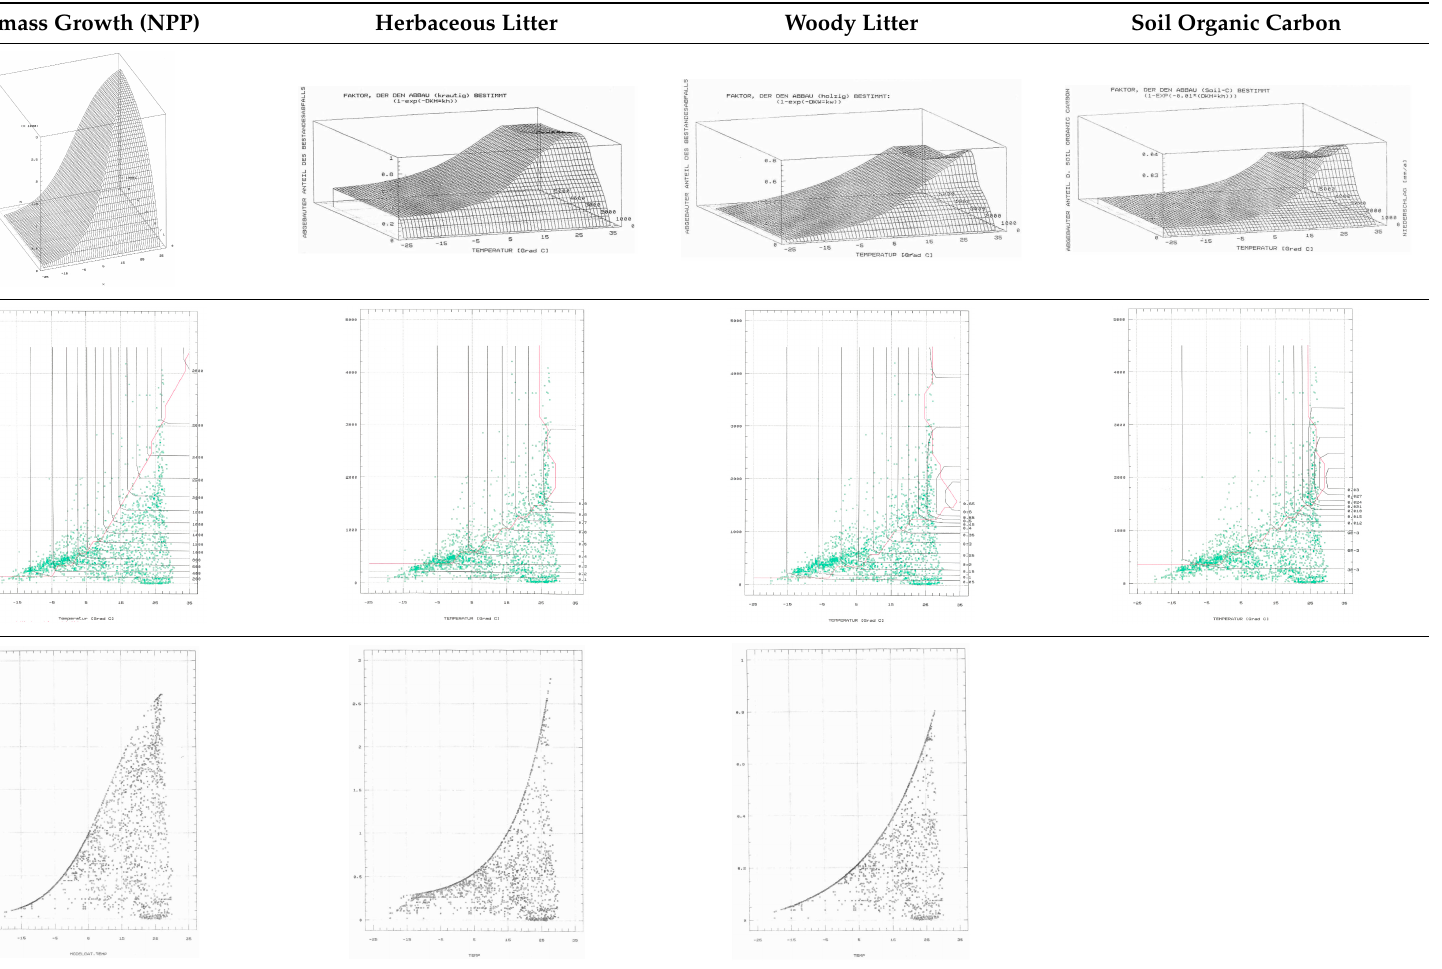
Table A1. The functions governing growth and decay of plants in the CEBM are displayed as a function of temperature and precipitation (first four rows) and the last two rows show the spatial and temporal patterns in the steady-state equilibrium of flows are shown. All images are produced by the author